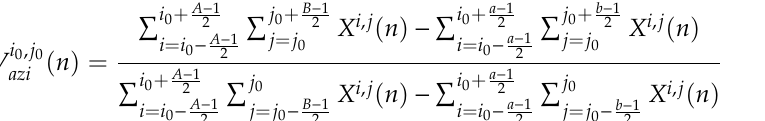
Table 1. VI conditions and the corresponding surface cases within the reference window.